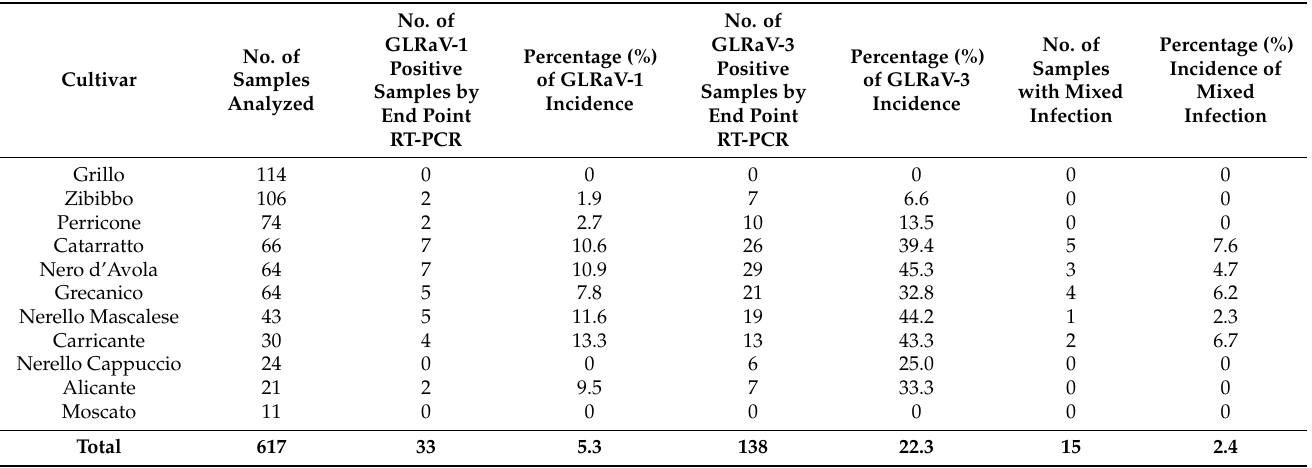
Table 4. Number of samples collected and incidence percentage of Grapevine leafroll-associated virus 1 and Grapevine leafroll-associated virus 3 obtained by specific end point